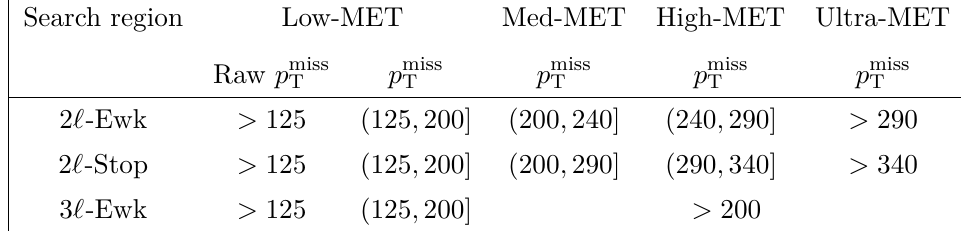
and p miss (in GeV) T T